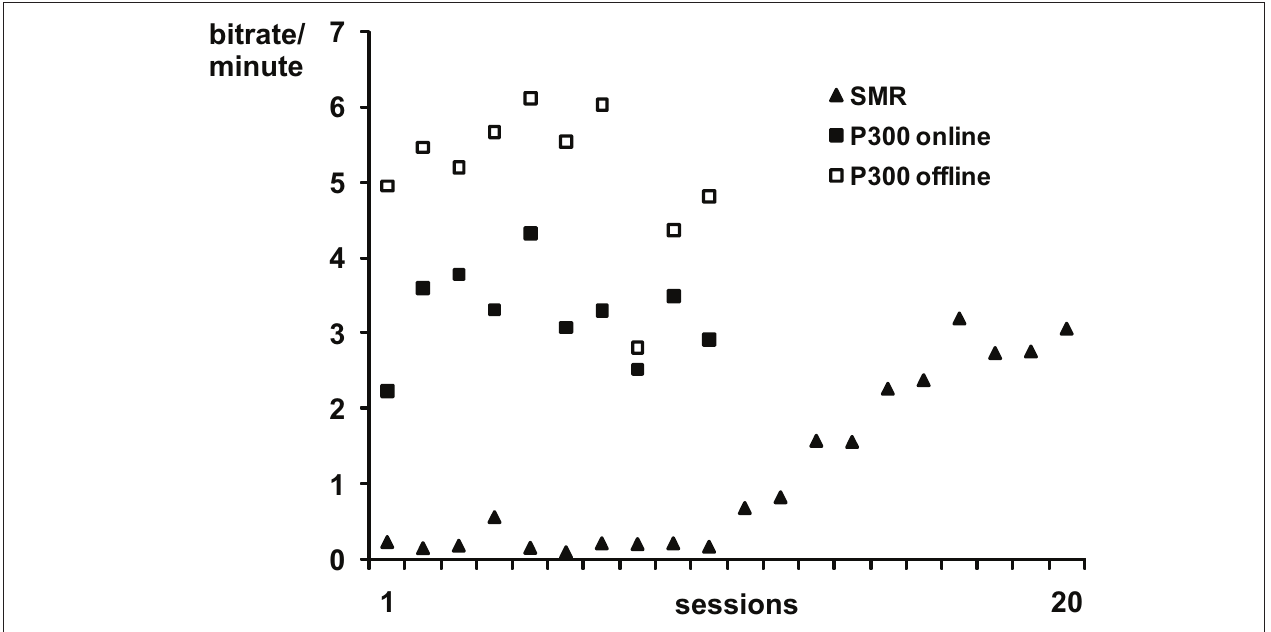
FIGuRE 1 | Average online bits per minute transferred per session in the SMR and P300-training. The offline analysis of the P300 training data is explained in Nijboer et al. (2008b). Note, that the SMR and P300 training were not conducted simultaneously, but successively